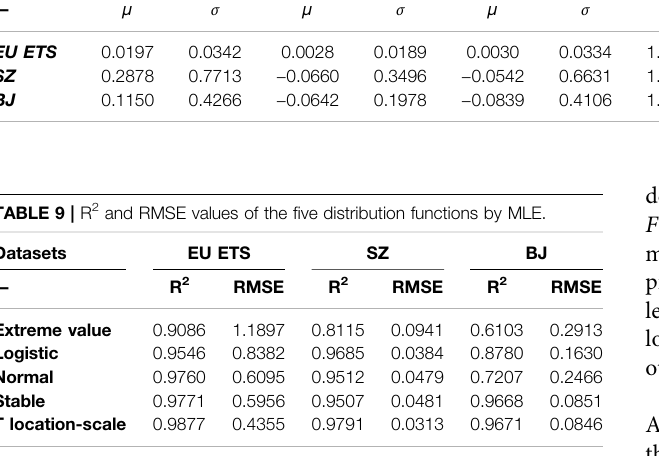
TABLE 8 | Parameter values of the different distribution functions determined by MLE. Datasets